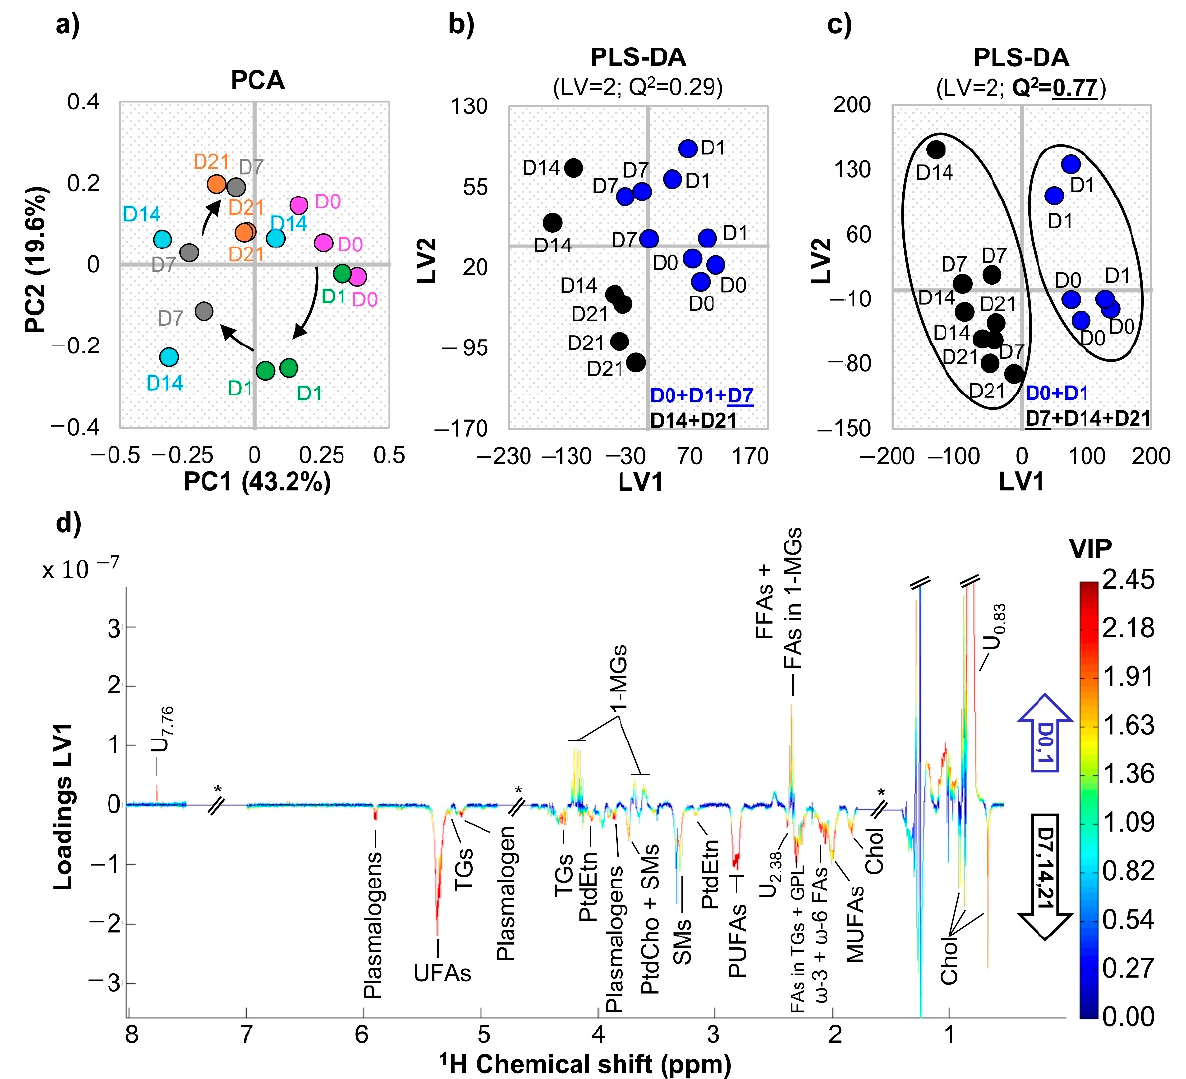
Figure 3. Multivariate statistical analysis considering full resolution 1 H NMR spectra of lipidic extracts from hAMSC throughout 21 days of osteogenic differentiation. ( a ) Scores scatter plots for principal component analysis (PCA) containing days 0 (pink), 1 (green), 7 (grey), 14 (blue), and 21 (orange), all in triplicate. ( b , c ) Scores scatter plots for partial least-squares discriminant analysis (PLS-DA) comparing the initial days of osteoinduction (blue) with the later days (black), considering day 7 as an ( b ) initial or ( c ) later day. ( d ) LV1 loadings plot (coloured according to variable importance to the projection, VIP) related to the PLS-DA model present in ( c ). Abbreviations as defined in Figure 2. Di: day i; LV: latent variables; Q 2 : predictive power; and U δ : unassigned signal at chemical shift δ .